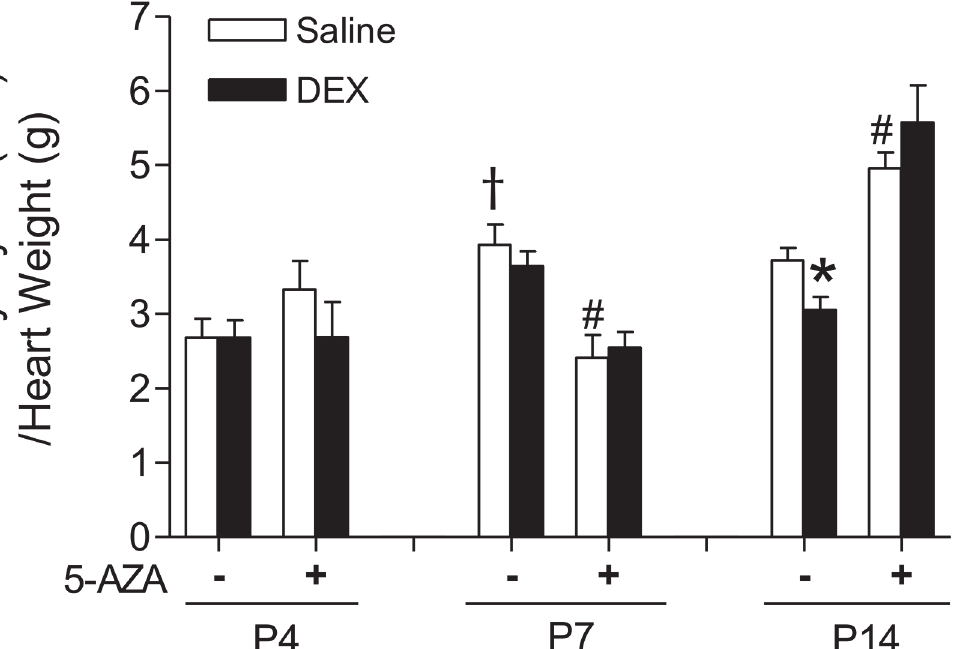
Fig 7. 5-AZA abrogates dexamethasone (DEX)-mediated effects on cardiomyocyte number in neonatal rats. Newborn rats were treated with tapered dose of DEX in the absence or presence of 5-AZA during the first three days of postnatal life. 5-AZA was administered 30 minutes prior to the DEX treatment. Cardiomyocytes isolated from day 4 (P4), day 7 (P7) and day 14 (P14) neonatal hearts were counted and normalized to per gram of heart weight. Data are mean ± SEM, n = 5 – 20. * p < 0.05, DEX vs . Saline; # p < 0.05, +5-AZA vs . -5-AZA; † p < 0.05, P7 vs . P4.